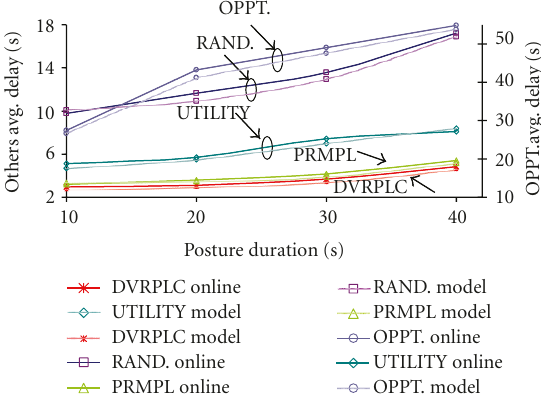
Figure 13: Impacts of posture duration on packet delay.